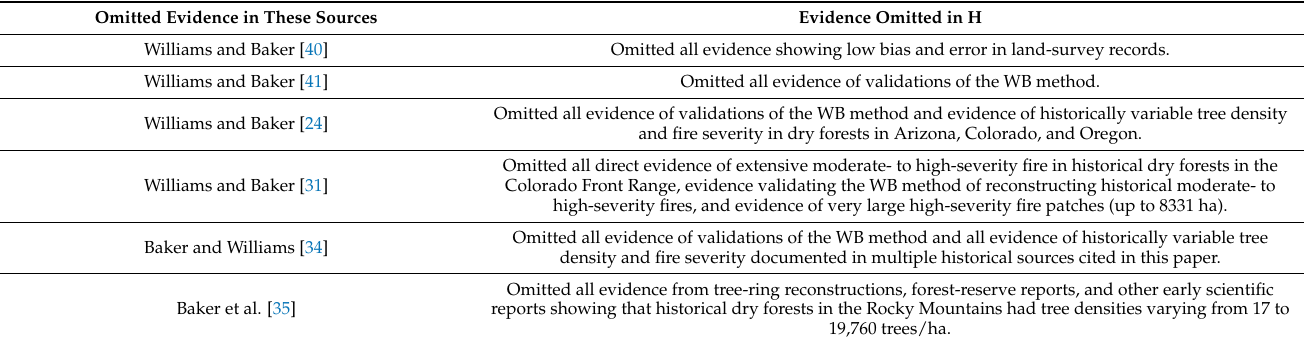
Table 9. Twenty-five original publications, with evidence of historically heterogeneous forest structure and mixed- to high-severity fires, omitted in